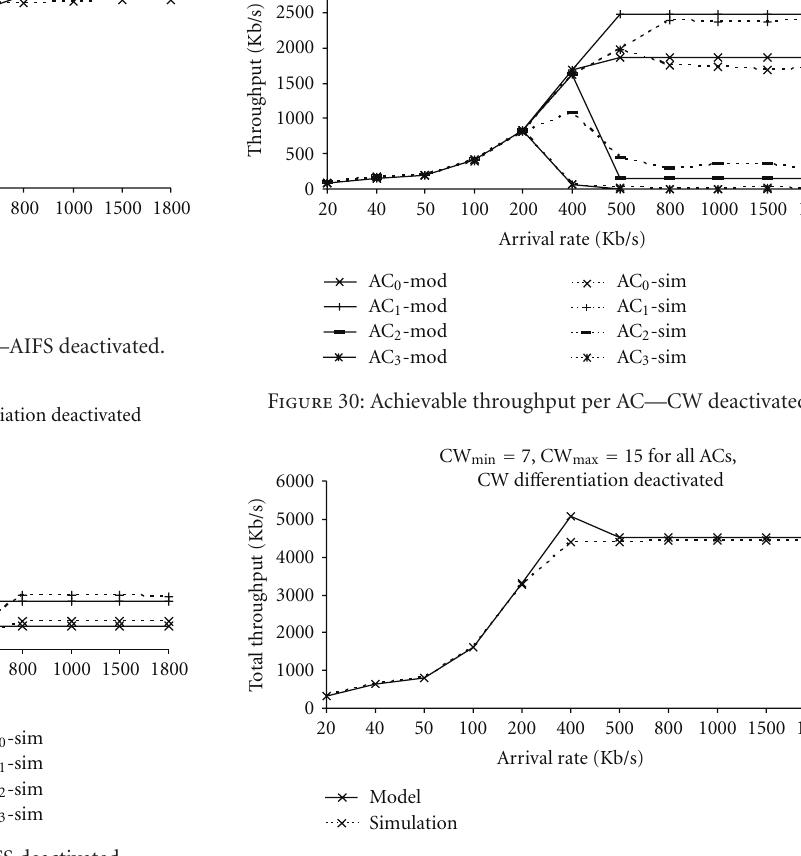
Figure 31: Total achievable throughput—CW